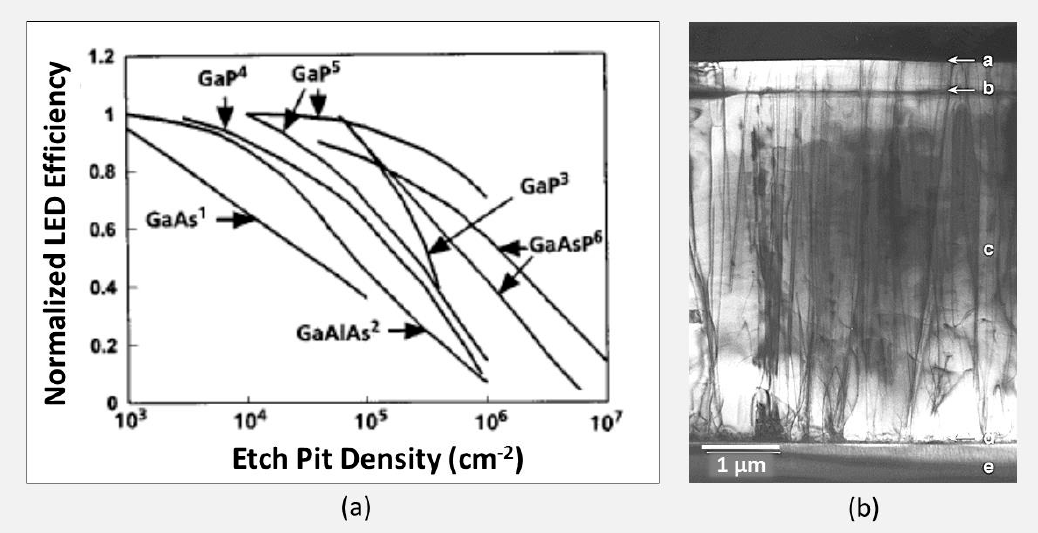
Figure 6. ( a ) The normalized Light Emitting Diodes (LED) efficiency as a function of the dislocation density in some traditional III-V semiconductor compounds. [23] (Reproduced from [23] with the permission of AIP Publishing); ( b ) cross sectional view of a Nichia GaN/GaInN/GaN/Sapphire based LED [24] with dislocation density in the range of 10 10 /cm 2 . (Reproduced from [24] with the permission of Nature ).